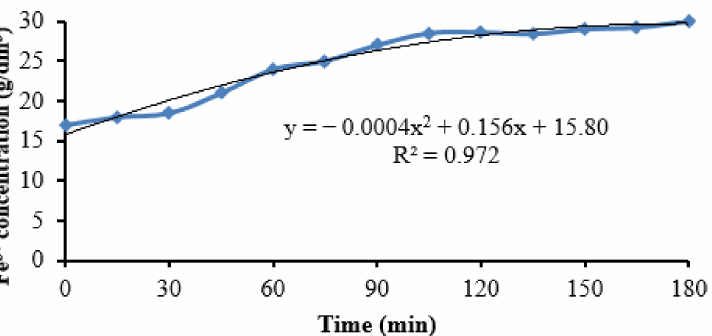
Figure 9. Fe(III) concentration change during electrooxidation in the flow electrolyzer (solution without preliminary iron precipitation).